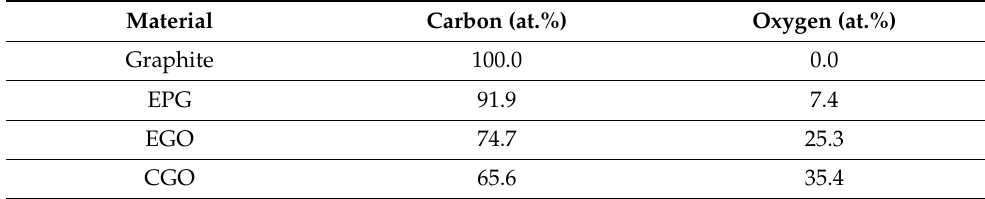
Figure 4. ( A ) Energy dispersive X-ray spectroscopy of EGO and CGO and ( B ) survey X-ray photoelectron spectroscopy of EGO and CGO and ( C ) high-resolution X-ray photoelectron spectroscopy (XPS) C1s for EGO and ( D ) high-resolution C1s for CGO. Table 1. Energy-dispersive X-ray spectroscopic data of the